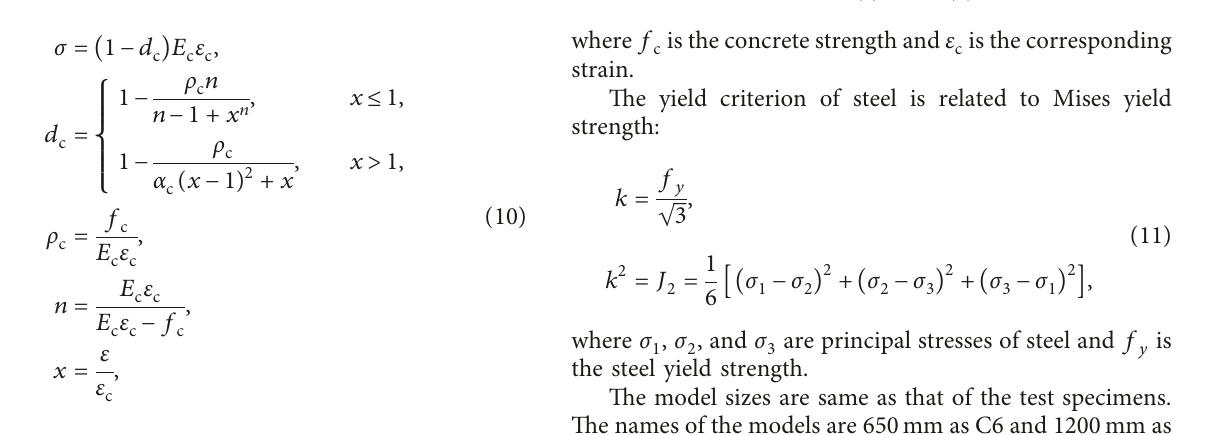
Figure 15: Concrete and steel tube stress distributions of models of structural failure: (a) C650; (b)